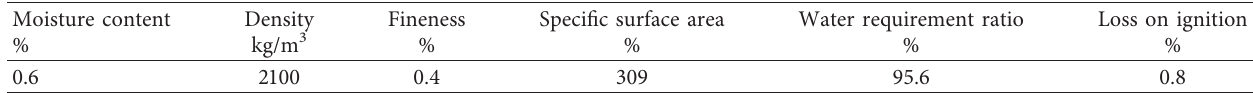
Table 4: Fly ash physical properties.